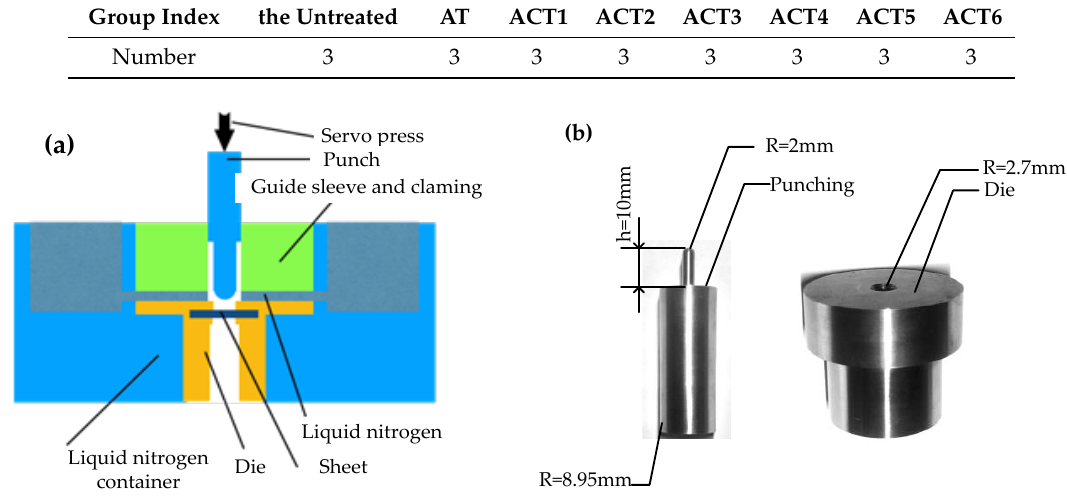
Figure 4. ( a ) The principle of deep drawing; and ( b ) the punch and die.